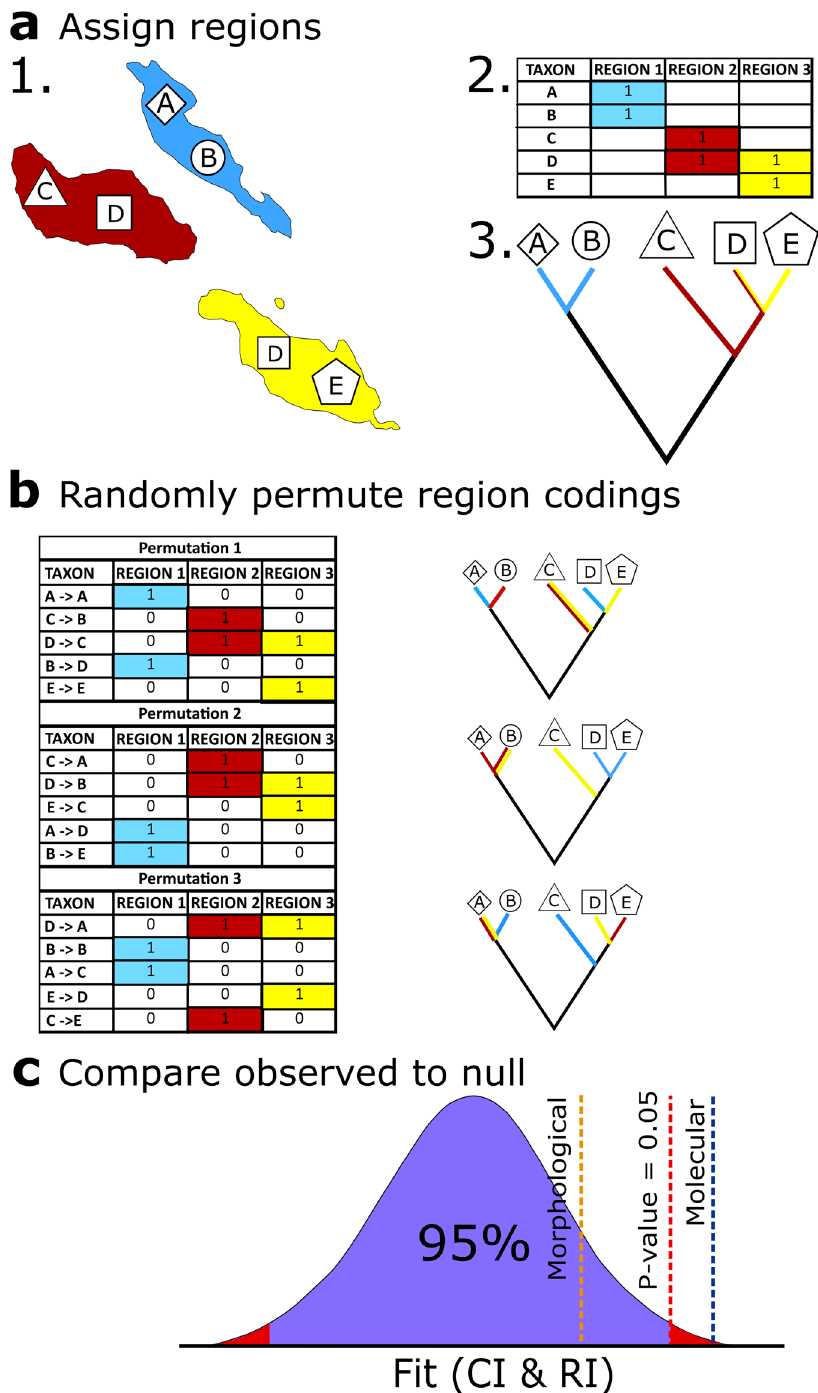
Fig. 1 Testing the biogeographic congruence of phylogenetic trees. a De fi ning biogeographic regions and coding taxon presences and absences. 1 . Occurrence data on the distribution of extant species is used to produce a list of biogeographic regions for the clade and to summarise ranges for the taxa in the published phylogenies. 2 . This distributional information is converted into a matrix of binary characters representing taxa in biogeographic regions, where 0 indicates the taxon is absent and 1 indicates the taxon is present. 3 . Characters in the occurrence matrix are mapped onto the morphological and molecular phylogeny selected for each clade, allowing standard measures of character fi t (CI, RI) to be calculated for each tree. b Presence and absence codings in each matrix are randomly reassigned to taxa, keeping the presence and absence codings fi xed for each row. Characters form the new randomly permuted matrix are mapped onto the original trees and both CI and RI are recalculated. The entire randomisation process is performed 10,000 times. c The 10,000 CI and RI values from matrices ’ biogeographic region reassignments form a null distribution of expected congruence values if taxa in the clade were randomly distributed in biogeographic regions. The observed CI and RI of region characters for a given tree is compared to the null distribution for that same tree to determine whether the observed biogeographic congruence value lies outside of the 95% con fi dence interval.